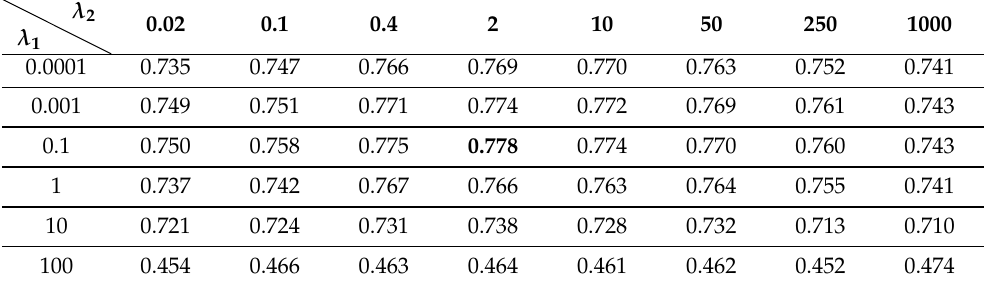
Table 7. The IoU performance of the proposed model with different hyper parameters (bold: best). λ